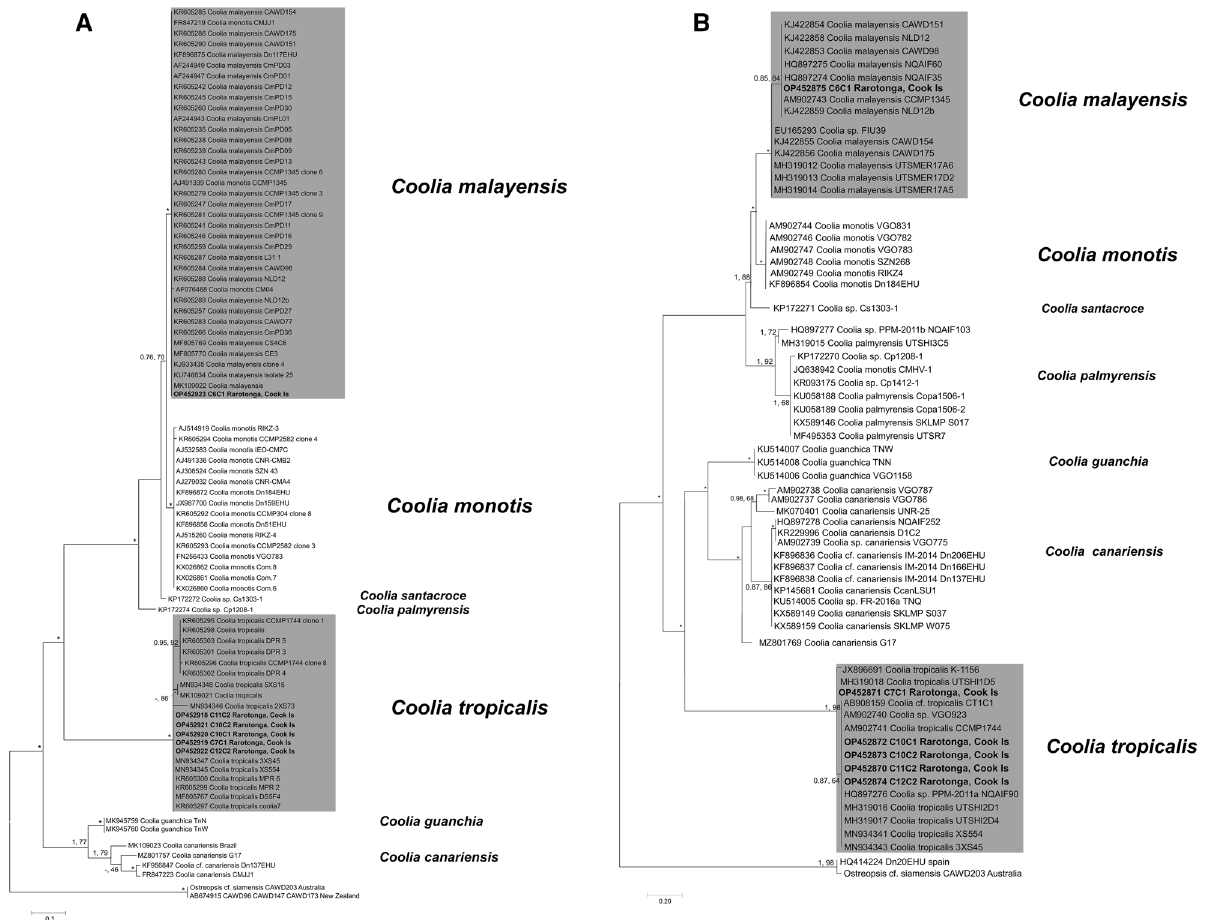
Figure 15. Maximum Likelihood (ML) phylogenetic tree of various Coolia strains using primer sets for ( A ) ITS/5.8S and ( B ) LSU D1-D3 rDNA. Numbers at nodes represent posterior probabilities from Bayesian Inferences (BI) and bootstrap support values from Maximum Likelihood (ML) based on 1000 pseudo-replicates. *represents 1, 100 support values for BI and ML respectively. Strains isolated is this study are indicated in bold and a grey